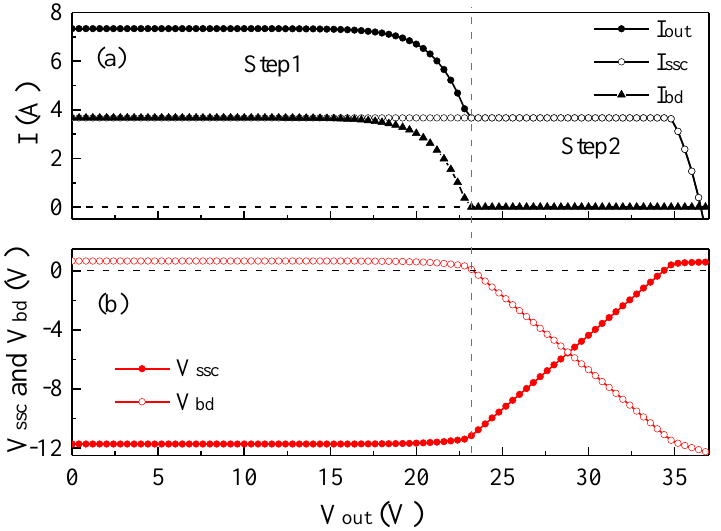
Figure 3. Output characteristics of the simulated PV module with a shading ratio of 50%. ( a ) Current of the simulated module (black dotted line), the shadowed solar cell (black circle line) and relevant bypass diode (black triangle line). ( b ) Terminal voltage of the shadowed solar cell (red circle line) and relevant bypass diode along with the I-V test (red dotted line).